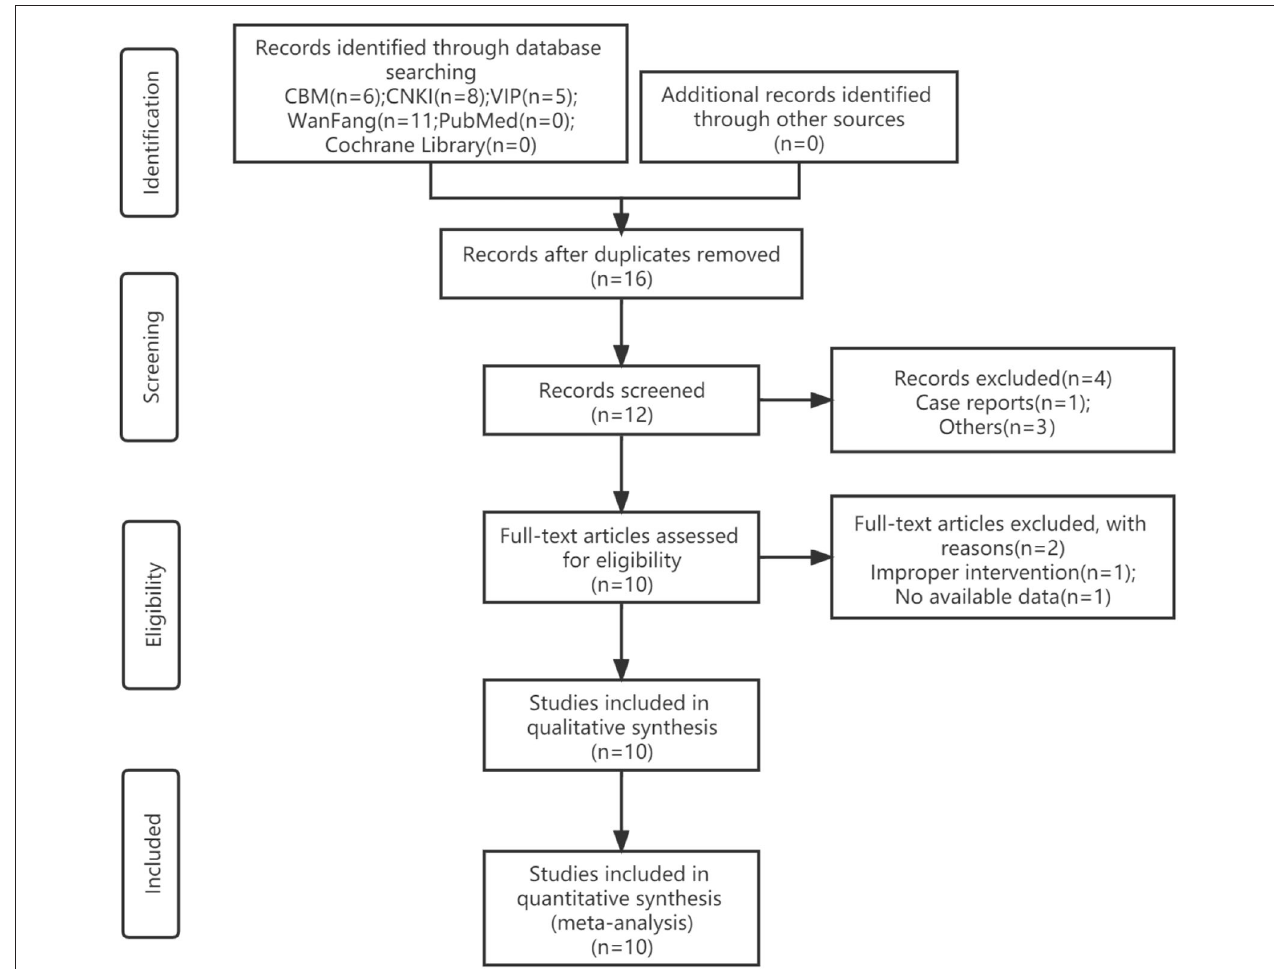
FIGURE 1 | Flow diagram of study selection and